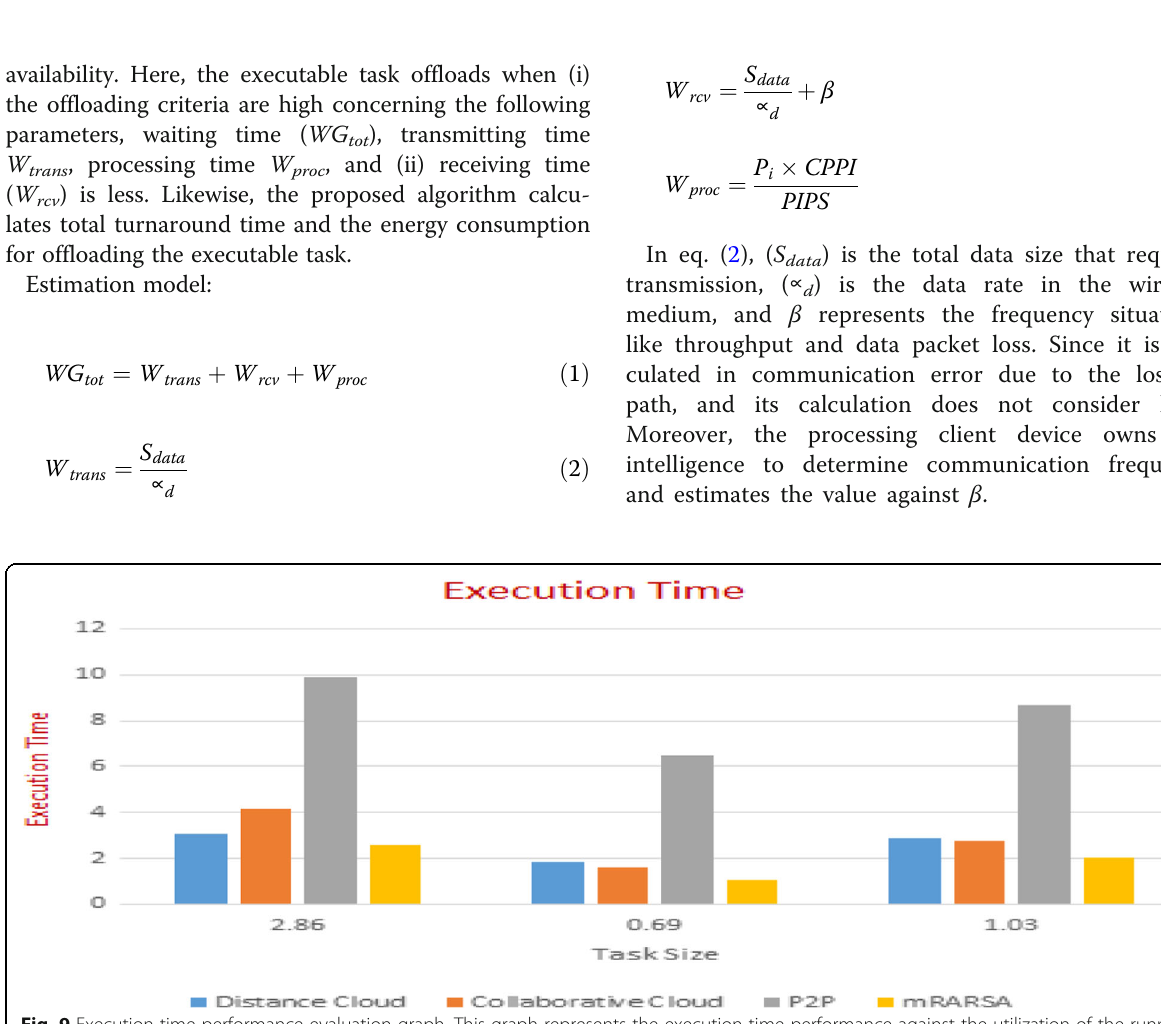
Fig. 9 Execution time performance evaluation graph. This graph represents the execution time performance against the utilization of the running cloud resources for first resource demanding text scanner (OCR)